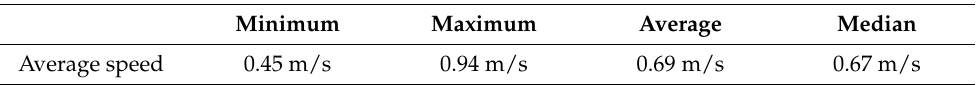
Table 1. Summary results from having test subjects use the lifejacket’s haptic navigation